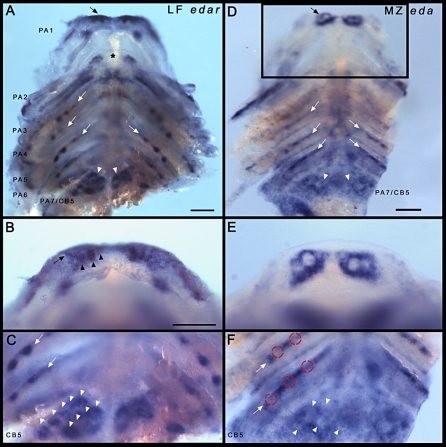
Ectodysplasin Pathway Genes, eda and edar, Are Expressed in Skeletal Structures throughout the Oropharynx
(A, B, and C) show edar expression in the lower pharyngeal elements of L. fuelleborni (LF) (6 dpf); dorsal views. (A) shows edar expression in the entire lower pharyngeal series. edar is localized to the epithelium of the tooth germs (black arrow) of the oral jaws (B) (arrowheads), in the surrounding epithelium along the mesiodistal axis in (B) (arrow), and in the pharyngeal endoderm including the hyoid arch (asterisk in [A]). edar is expressed in gill raker bud epithelium (similar to tooth germs) on pharyngeal arches PA3–6 and in a band of gill raker initiation along the mesiodistal axes of each gill-bearing arch (white arrows in [A] and in [C]). edar also labels in the epithelial cells of the pharyngeal tooth germs on PA7 (white arrowheads in [A] and in [C]).(D, E, and F) show eda in the lower pharyngeal elements of M. zebra (MZ) (7dpf); dorsal views. (D) shows eda expression in the lower pharyngeal series of MZ. (D) is composed of two images of the same specimen; the boxed area of the oral jaw (separate image) is shown in (E). eda expression marks the mesenchymal cells surrounding and separating the tooth germs of the oral jaw (black arrow in [D]; open circles surrounded by eda expression represent the epithelial tooth germs; also see [49]), through to the equivalent cells surrounding the tooth germs of the pharyngeal jaw, PA7 (white arrowheads in [D] and in [F]). Between these separated dental sites, eda also labels the medial pharyngeal mesenchyme from the hyoid (PA2), including the second arch extension that will form the opercular flap (black arrowhead), through the series to the most posterior arch (PA7). eda is also expressed in relation to the initiating gill rakers lining each of the gill-bearing arches, PA3–6 (white arrows). Breaking up the bands of expression are eda-negative sites of gill raker bud initiation (red dashed circles) that express edar in (C).Scale bar in (B) represents 100 μm; (B, E, C, and F) are all to the same scale. Scale bars in (A and D) both represent 100 μm.CB5, ceratobranchial 5.